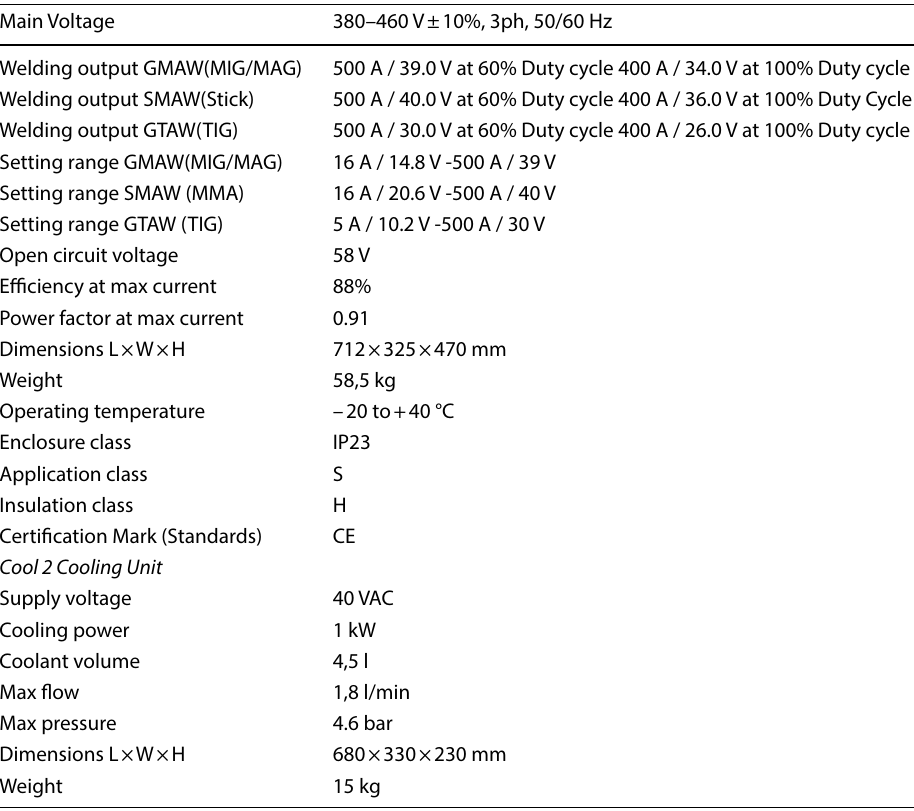
Table 1 Welding power source specifications